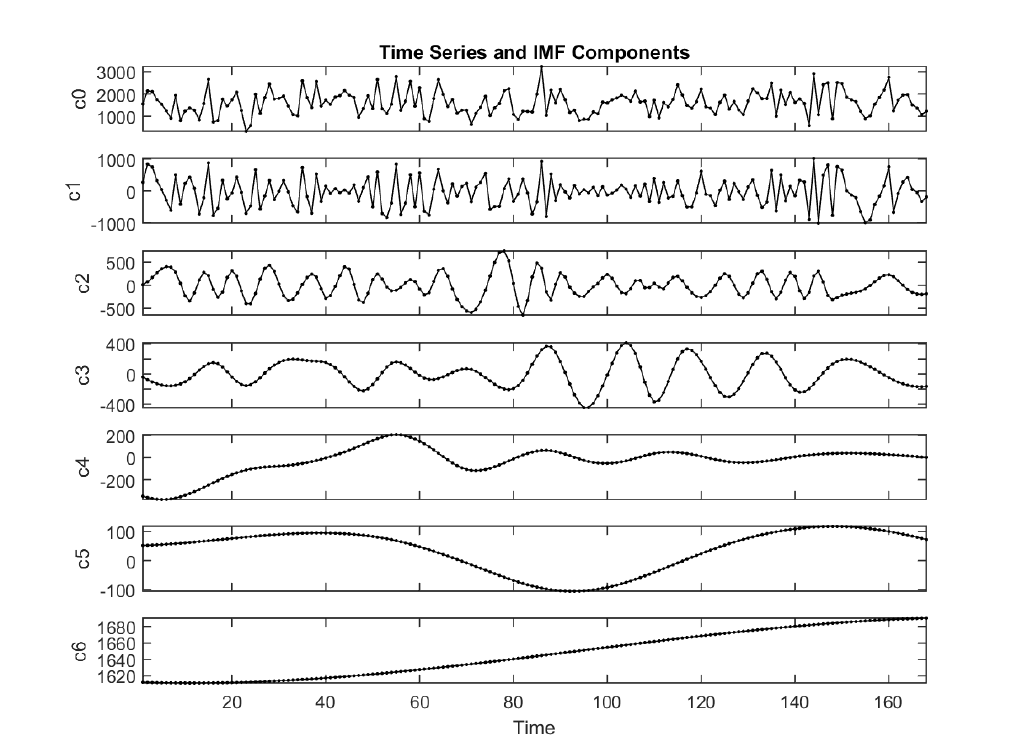
Figure 2. EMD of precipitation data over Caspian catchment, (C 0 ) 14-year monthly precipitation, (C 1 -C 6 ) decomposed five IMF components and the final residue(C 6